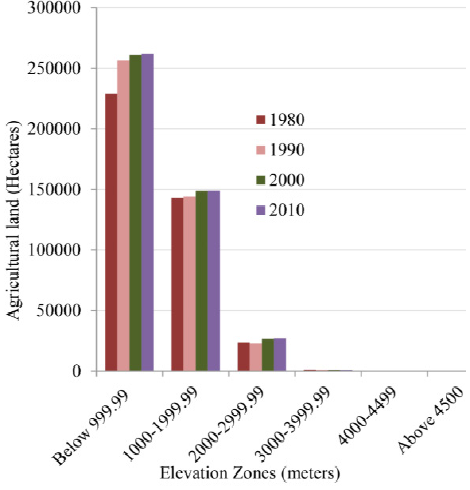
Figure 5. Distribution of agricultural land by elevation. The higher the elevation the lesser the agricultural land. (Source: Population from the Center Bureau of Statistics (CBS), agricultural land from and analyses of satellite imagery for the years of 1980, 1990, 2000, and 2010. These images were gathered from United States Geological Service (USGS) and classified by the authors).